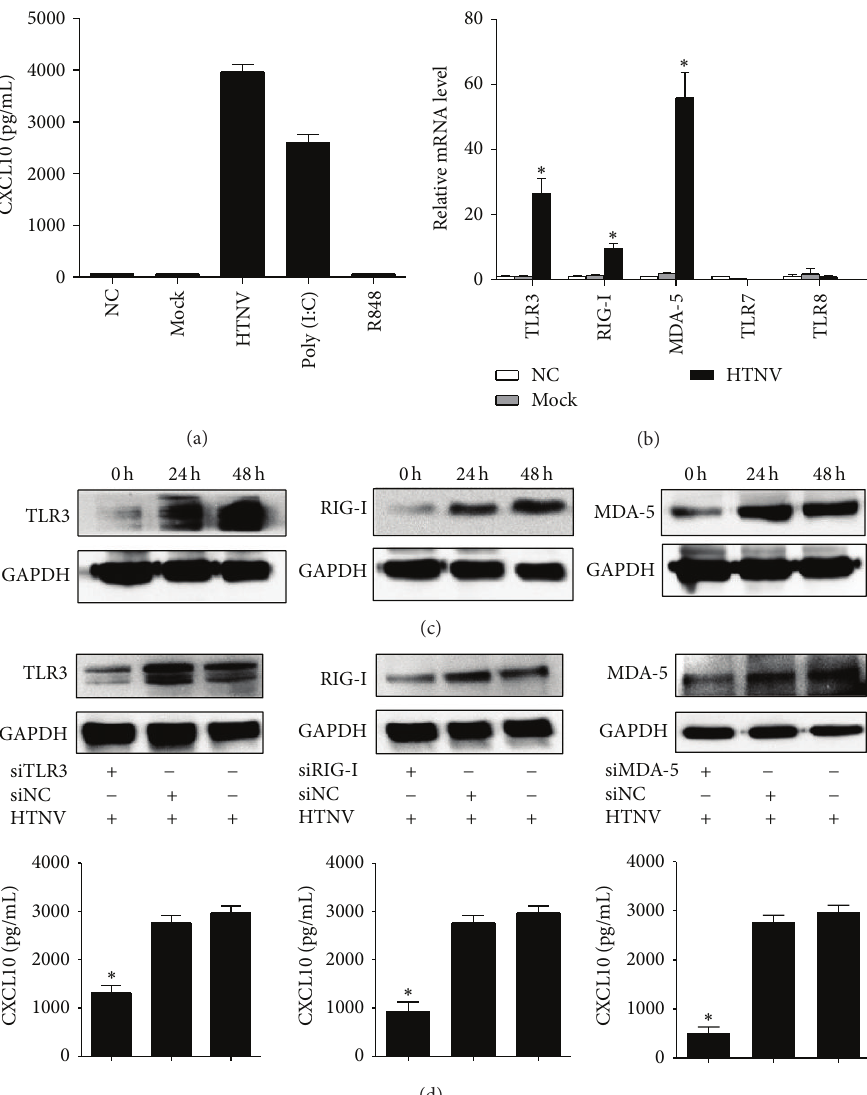
Figure 3: HTNV infection activates TLR3, RIG-I, and MDA-5 signaling pathways. (a) In HUVEC model, both the HTNV infection and poly (I:C) stimulation for 48h can induce the expression of CXCL10. However, mock HTNV infection and R848 treatment for 48 h failed to raise the expression of CXCL10. (b) Real-time PCR screened out that TLR3, RIG-I, and MDA-5 upregulated after HTNV infection for 48h. (c) WB results indicated that the protein expressions of TLR3, RIG-I, and MDA-5 increased at 24 h and 48 h post-HTNV infection. (d) When transfected into HUVECs for 24 h with siRNA (upper panel), specific to TLR3, RIG-I, or MDA-5, respectively, and then infected the cells with HTNV (MOI = 1) for another 48 h, the expressions of CXCL10 reduced (lower panel). All the experiments were repeated more than three times. mRNA data were generated from three independent experiments with three independent HUVECs donors. Data were means ± SE. ∗ 𝑃 < 0.05 , HTNV infected or poly (I:C) treated versus medium treated cells; and siRNA specific to TLR3, RIG-I, or MDA-5, versus siNC treated